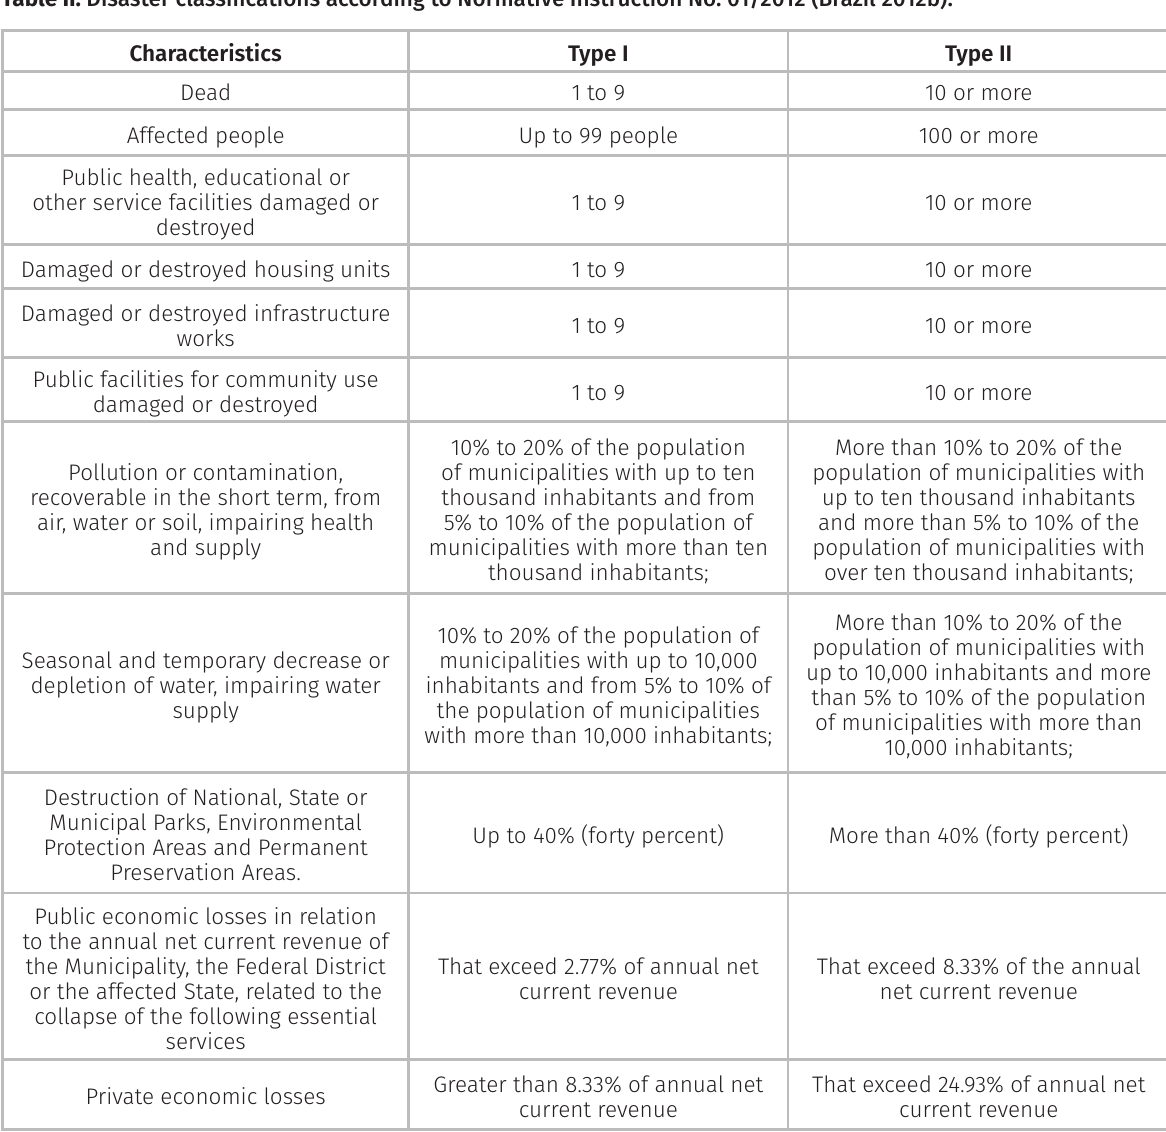
Table II. Disaster classifications according to Normative Instruction No. 01/2012 (Brazil